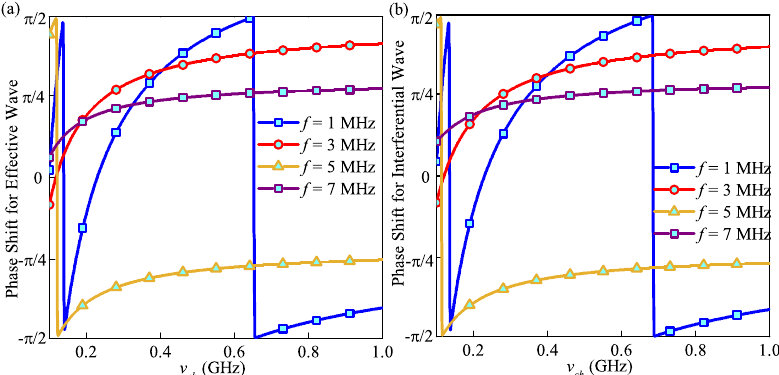
Figure 6. Phase shift for the ( a ) effective wave and ( b ) interferential wave versus dust charging frequency under four wave